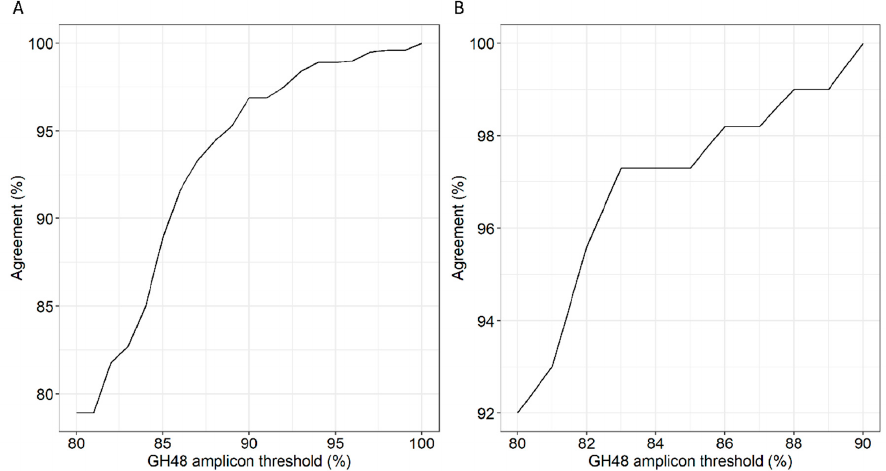
Figure 2. GH48 sequences clustering agreement with National Center for Biotechnology Information (NCBI) taxonomy. GH48 nucleotide sequences were clustered at a range of sequence identity at 1% increment using USEARCH [35]. ( A ) Clustering agreement of amplicon sequences based on GH48-16S dataset. All sequences were correctly clustered at genus level at 100% sequence identity; ( B ) Clustering agreement of amplicon sequences based on GH48-16S-C dataset. All sequences were correctly clustered at genus level at 90% sequence